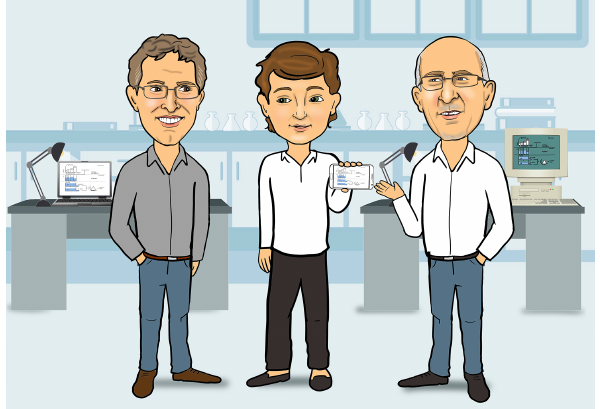
Figure 1. Discussion of hydrological catchment modelling between Jan, a PhD student and Sten. The smartphone that the PhD student is holding in her (or his) hand is far more powerful than the computers available when Sten started developing the HBV model in the early 1970s (drawing by Steph’s Sketches).